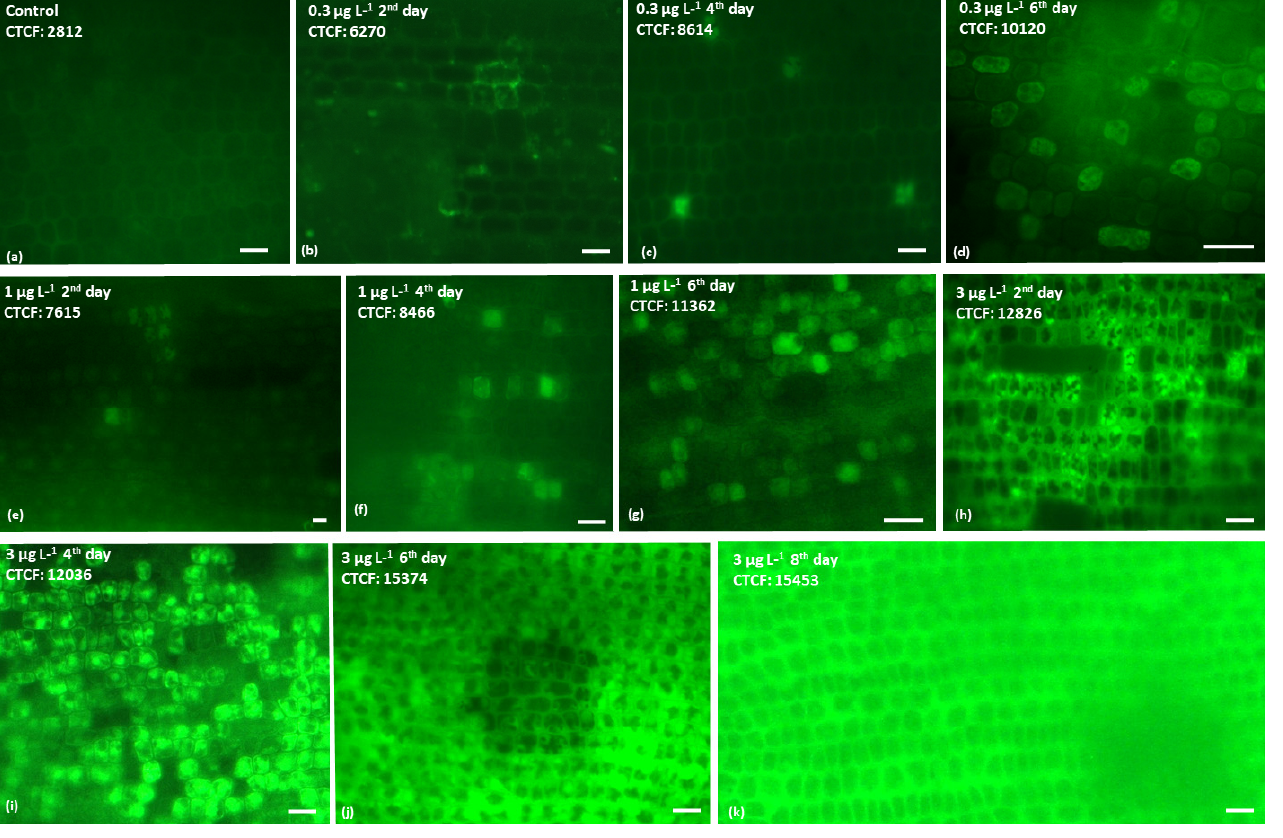
Figure 1. Indicative fluorescence images of hydrogen peroxide (H 2 O 2 ) after H 2 DCF-DA staining in Cymodocea nodosa intermediate leaves, at control ( a ), 0.3 ( b – d ), 1 ( e – g ) and 3 ( h – k ) µ g L − 1 BPA treatments, on 2, 4, 6 and 8 days. The corrected total cell fluorescence (CTCF) values are depicted on the images. Scale bars: 50 µ m. Table 1. CTCF values (Corrected Total Cell Fluorescence) (mean ± SE) in BPA treated (0.3, 1 and 3 µ g L − 1 ) Cymodocea nodosa intermediate leaves and in the Control (C), after 2, 4, 6 and 8 days. Comparison (Mann-Whitney U-test) of the mean CTCF values at each BPA treatment and each incubation time with the respective values in the control is also given. N = 54 values per concentration and